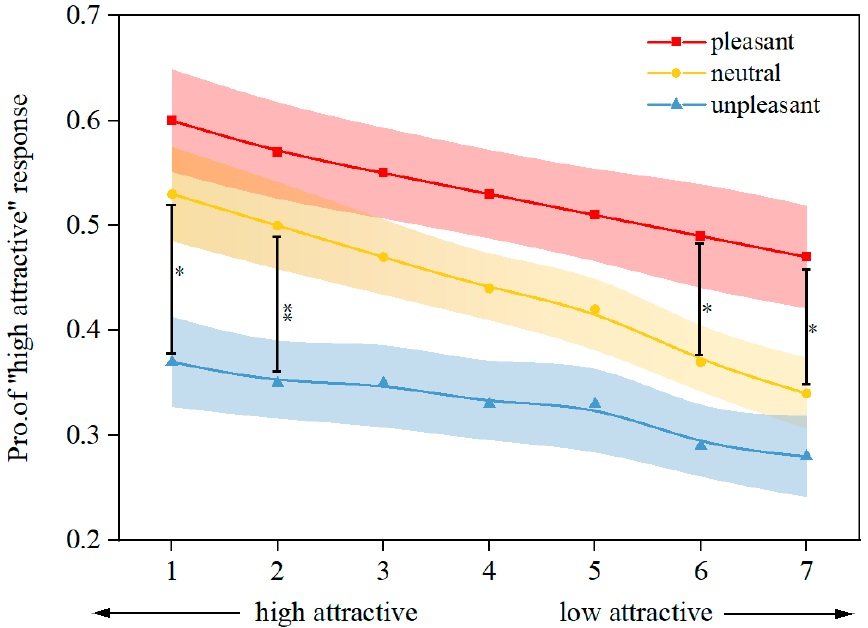
Figure 3. Effects of odor valence and morphing levels on the proportion of responses choosing “high-attractive” faces. As a function of morphing level and odor condition, the proportions of faces classified as highly attractive are shown. The variations were calculated. Significant differences between conditions are indicated using one-way ANOVA (a black dash line between the dots of levels 1, 2, 6, and 7). * p < 0.05, ** p < 0.01.